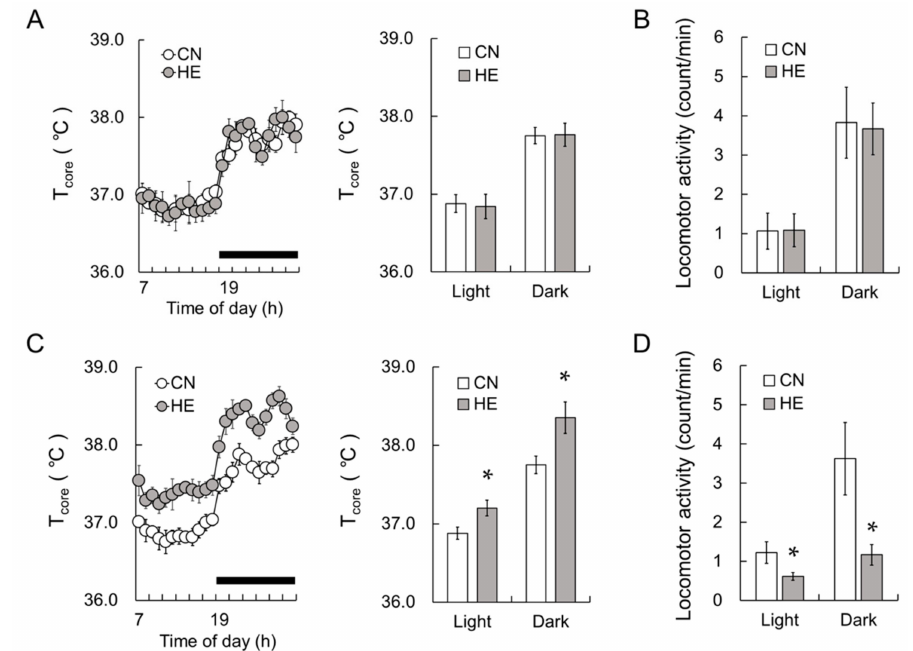
Figure 1. The core body temperature (T core ) and locomotor activity of control (CN) and heat-exposed (HE) rats. ( A ) The left graph shows T core of CN (open circle) and HE (gray circle) rats measured 1 day before the heat exposure period. The right graph presents mean T core in the light (Light) and dark phases (Dark) in the CN (open column) and HE groups (gray column). ( B ) Locomotor activity of CN (open column) and HE rats (gray column). T core and locomotor activity for ( A ) and ( B ) were measured 1 day before heat exposure. ( C ) The left graph indicates T core in the CN and HE groups during heat exposure. The right graph presents mean T core in the light and dark phases in the CN (open column) and HE groups (gray column) during heat exposure. Dark bars above the abscissa indicate the dark phase data. ( D ) Locomotor activity in the CN (open column) and HE groups (gray column). T core and locomotor activity for ( C ) and ( D ) were measured on 2nd to 5th day of heat exposure and summarized for 24 hours. Values are presented as the mean ± SEM ( n = 8 in each group). * p < 0.05, significant di ff erence between the CN and HE groups.